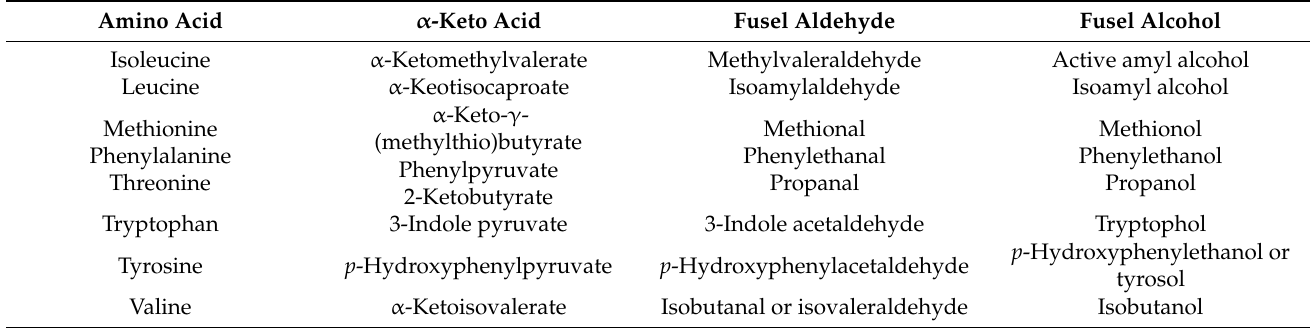
Figure 4. Distillation column with a fusel alcohol draw near the middle of the column. The fusel alcohols can be removed from the distillation process and decanted, reusing the higher alcohols and removing the aqueous phase. Without a fusel alcohol draw, the fusel alcohols will fall in the column and form a two-phase system. This can interfere with the distillation efficiency.